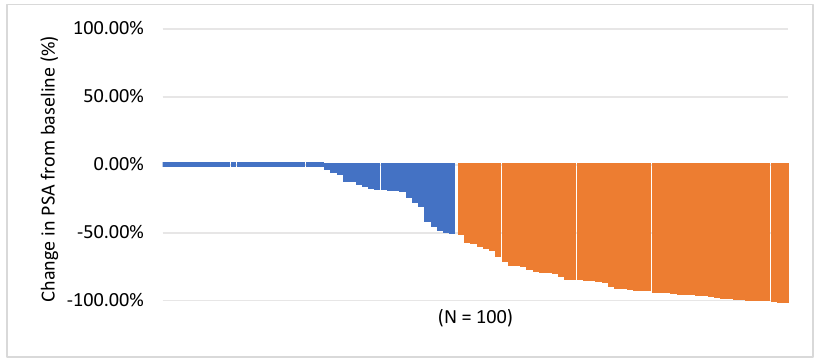
Figure 1. Best PSA response. Prostate-specific-antigen (PSA) response defined as PSA value ≥ 50% below baseline [12]. The DCR by week-12 68 Ga-PSMA-11 PET/CT was 64% (29% SD; 34% PR; and 1% CR) (Figure 2).